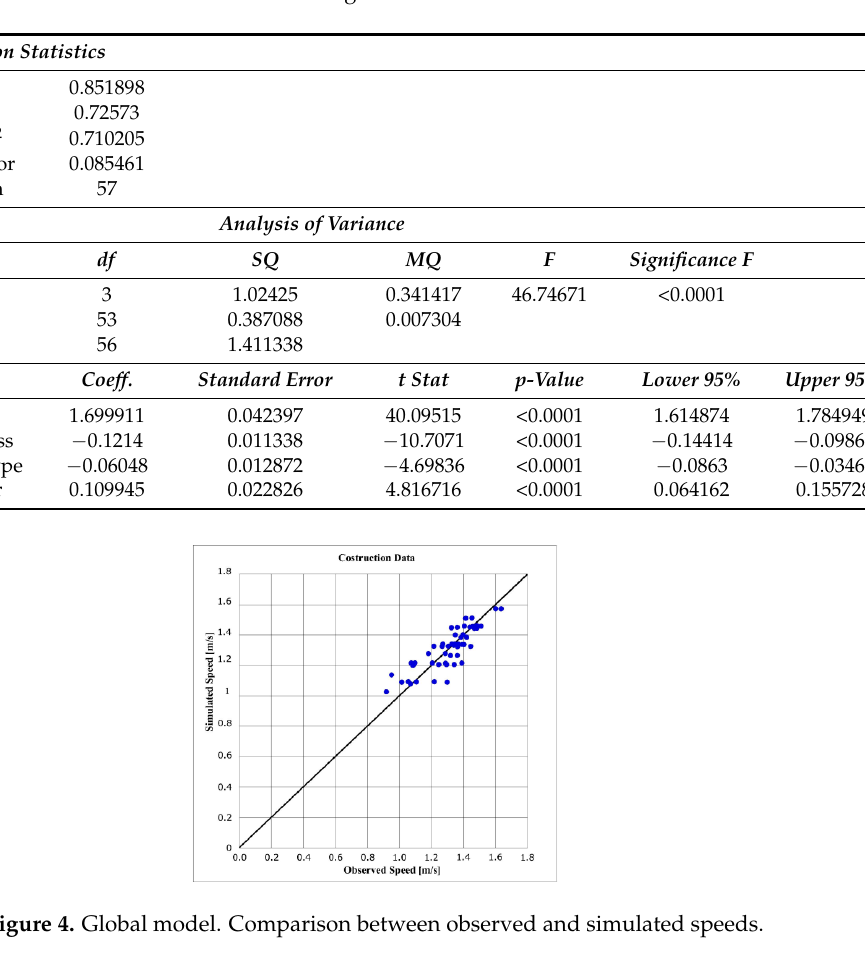
( b ) Figure 5. Comparison between the observed and estimated datasets: construction phase ( a ); and validation phase ( b ).